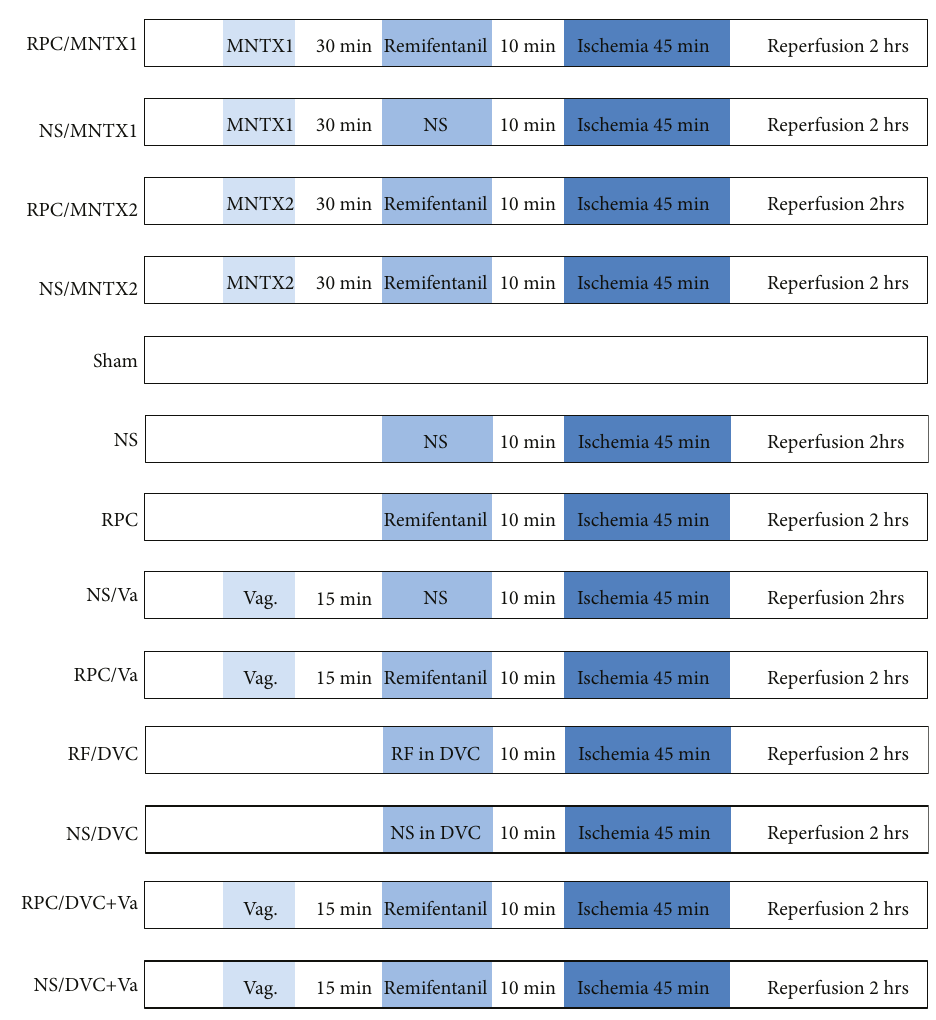
Figure 1: The protocols followed for all series of experiments are presented as listed. RPC: remifentanil preconditioning; NS: normal saline; MNTX1: 0.5mg · kg − 1 of MNTX; MNTX2: 5 mg · kg − 1 of MNTX; Va: vagotomy; RF: remifentanil; DVC: dorsal vagal